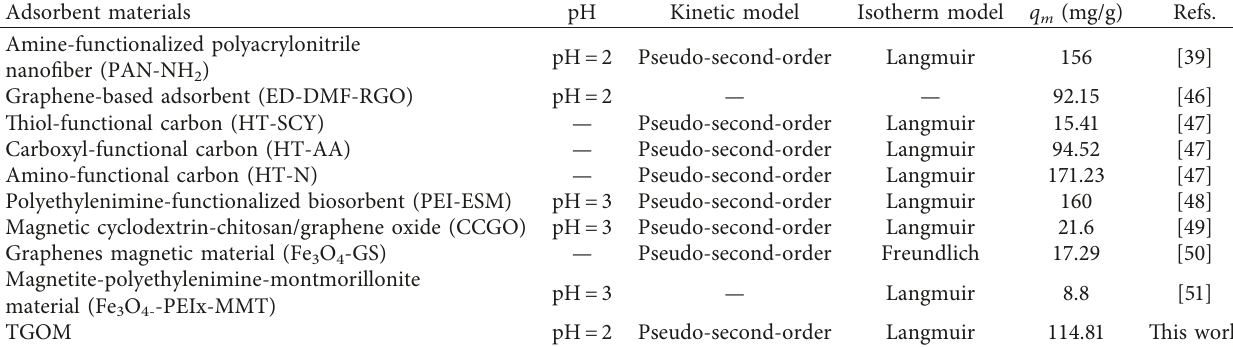
Table 3: Comparison of adsorption capacity for removal of Cr (VI) on TGOM with other materials.